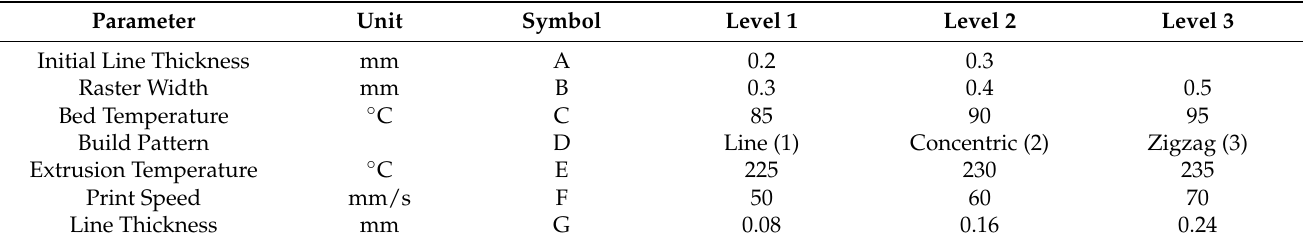
Table 2. FFF 3DP parameters used to print ABS polymer sample.